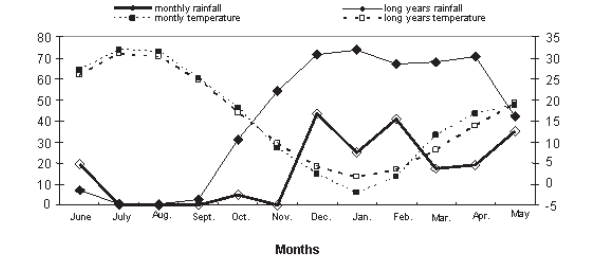
Fig. 1. Average air temperatures ( o C) and the amount of rainfall (mm) of the research area